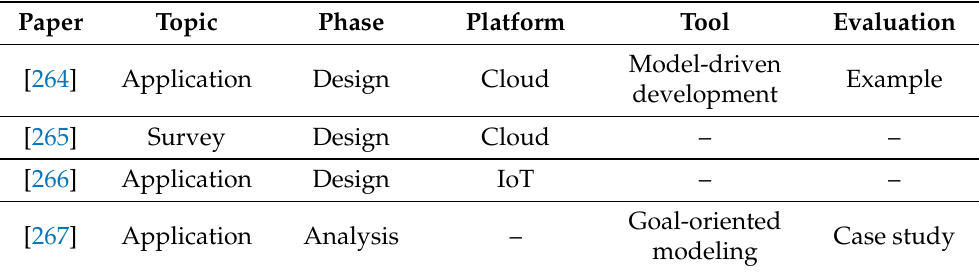
Table 5. Classification of latest papers: Purpose and Research implementation.